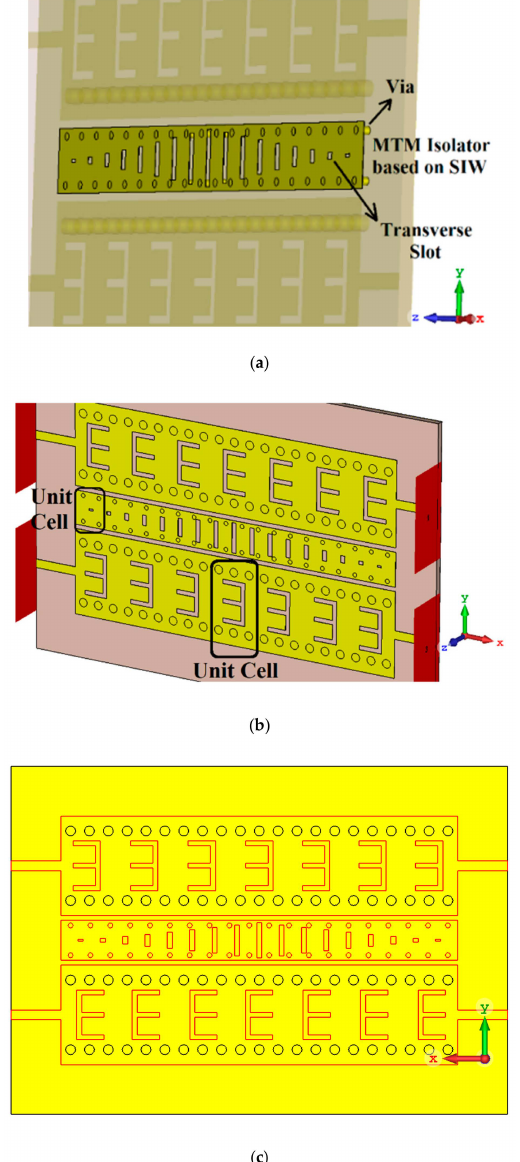
Figure 4. Proposed SIW-based leaky-wave antenna array with MTM-shield. ( a ) Proposed MTM-SIW shield located between the array antennas; ( b ) top-view of the leaky-wave array antennas; ( c ) back-side to show ground plane.